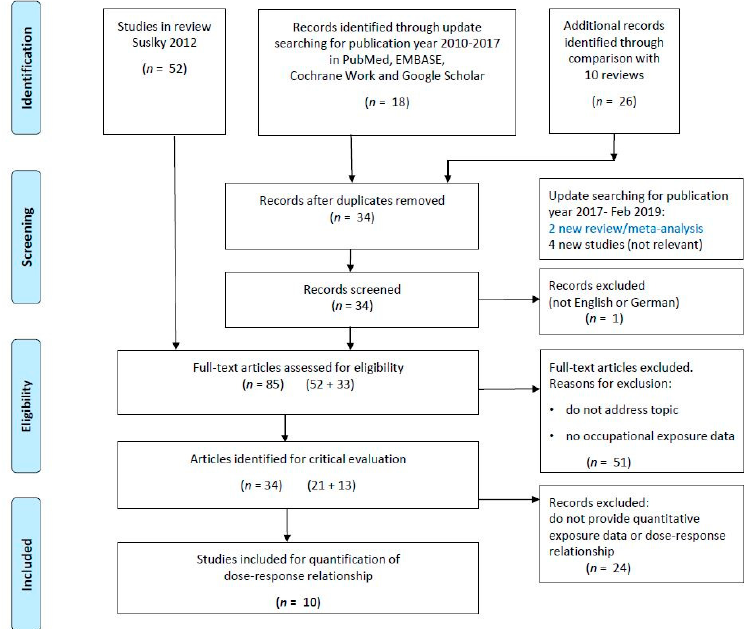
Figure 1. Preferred Reporting Items for Systematic Reviews and Meta-Analyses (PRISMA) flow diagram for the selection of literature for critical evaluation.